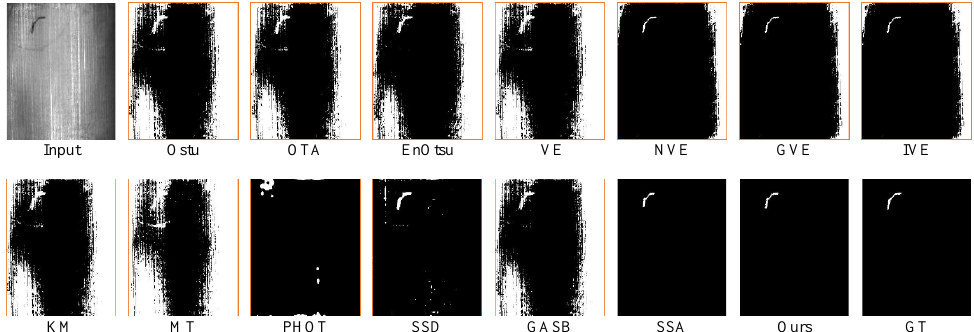
Figure 4. Result of different methods on magnetic tile images with crack defect. Visual comparisons of detection results of the fourteen methods on magnetic tile images with crack defect. NVE, GVE, IVE, SSD, SSA, and the proposed method (ours) are capable of identifying the defect location.